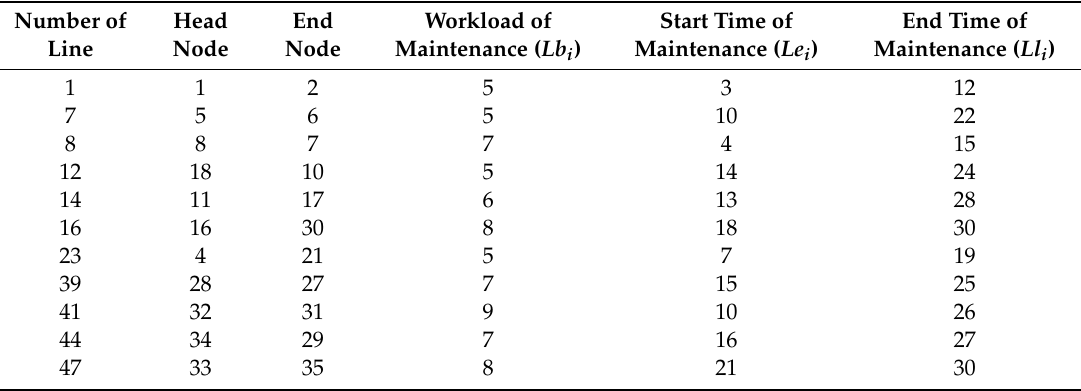
Table 4. Information of the overhead transmission lines to be maintained in Hubei Province. Number